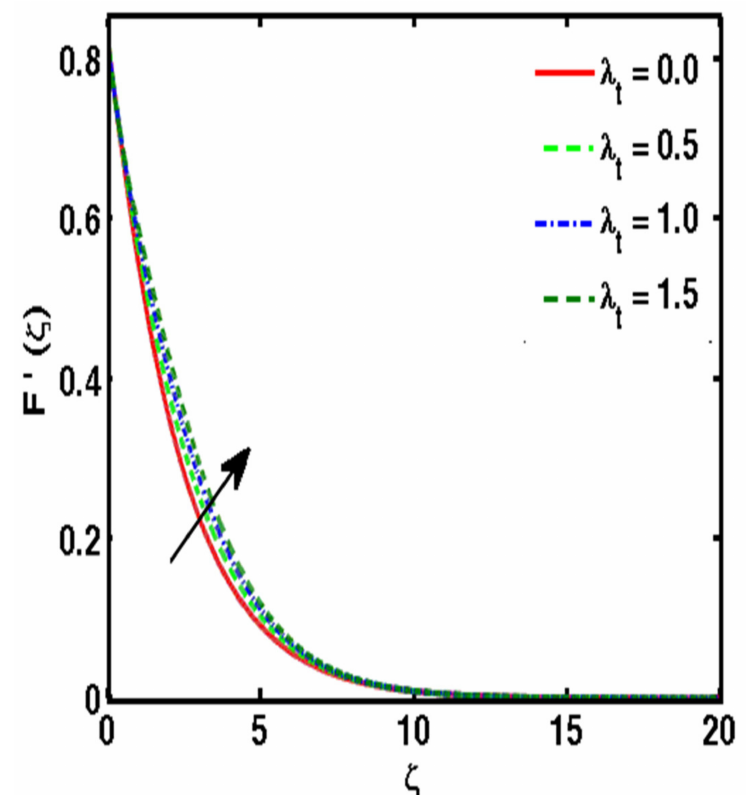
Figure 7. Variation of λ t and F (cid:48) ( ζ ) .